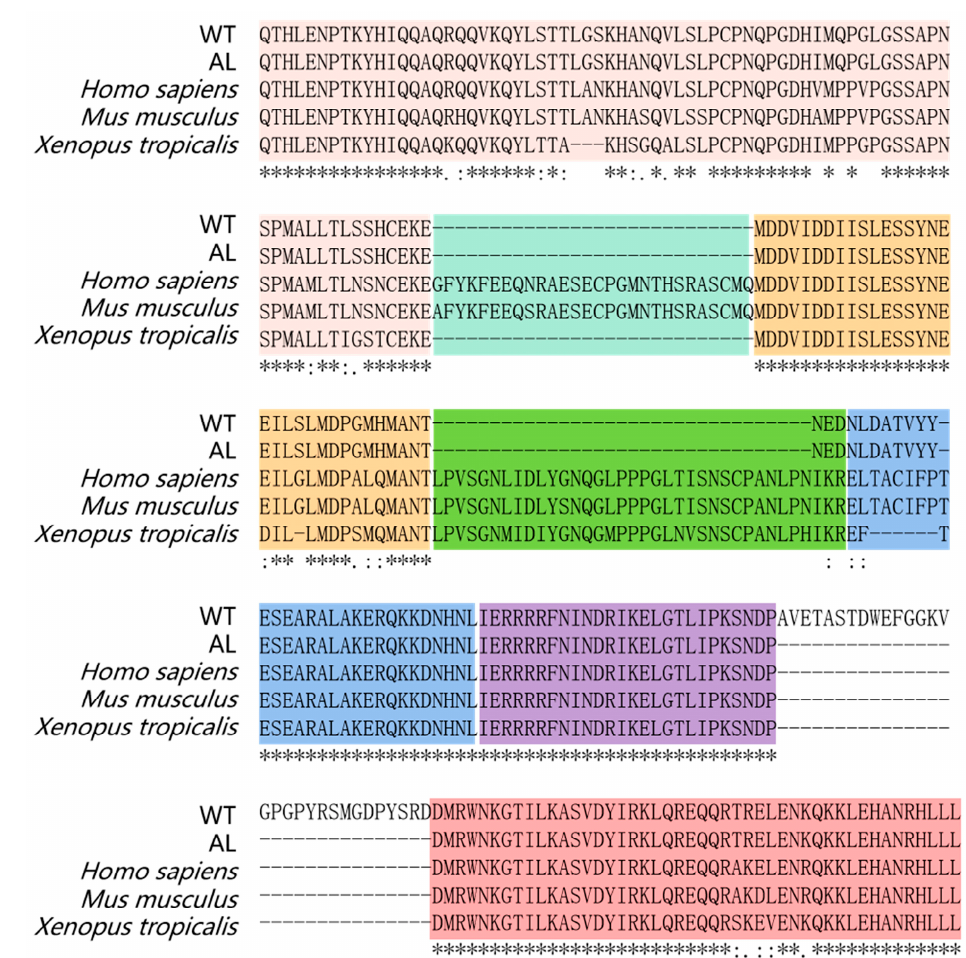
Figure 4. Protein sequence alignment of MITF between WT, AL Andrias davidianus, and other vertebrates. The colored boxes mark exons 2–8 of MITF.